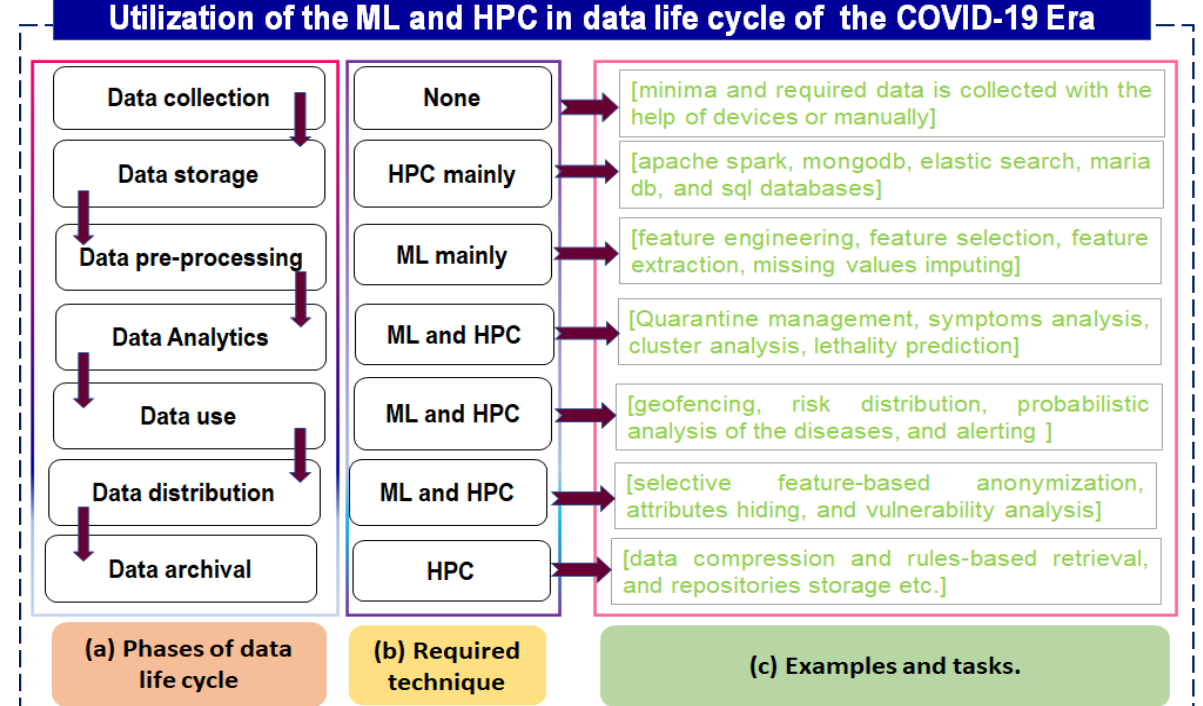
Figure 4. Role of ML and HPC in the data life cycle to fight COVID-19 through